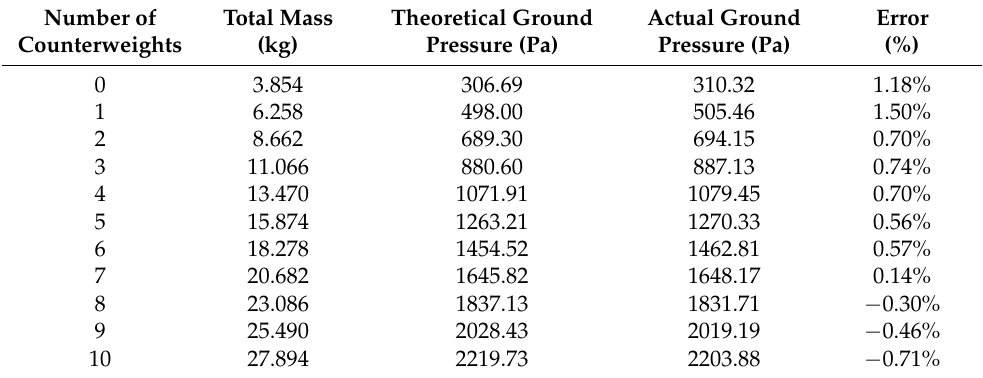
Table 2. Ground pressure calibration